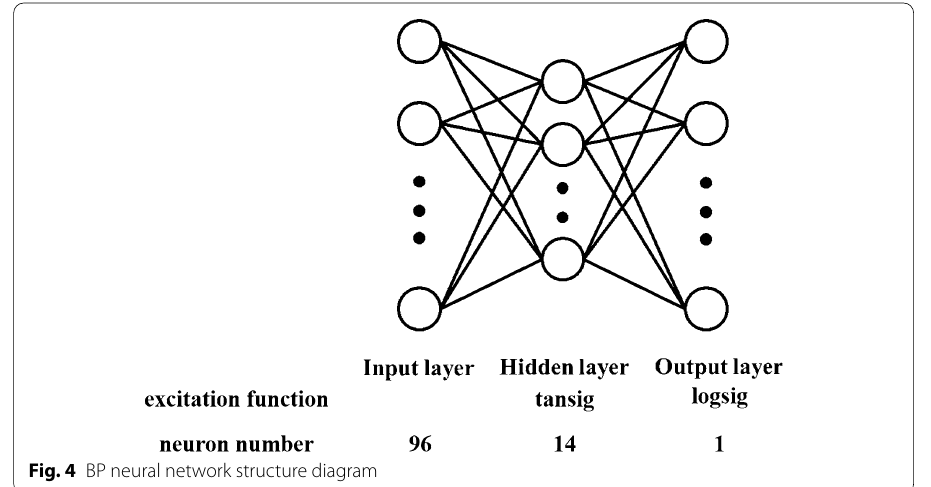
Fig. 4 BP neural network structure diagram